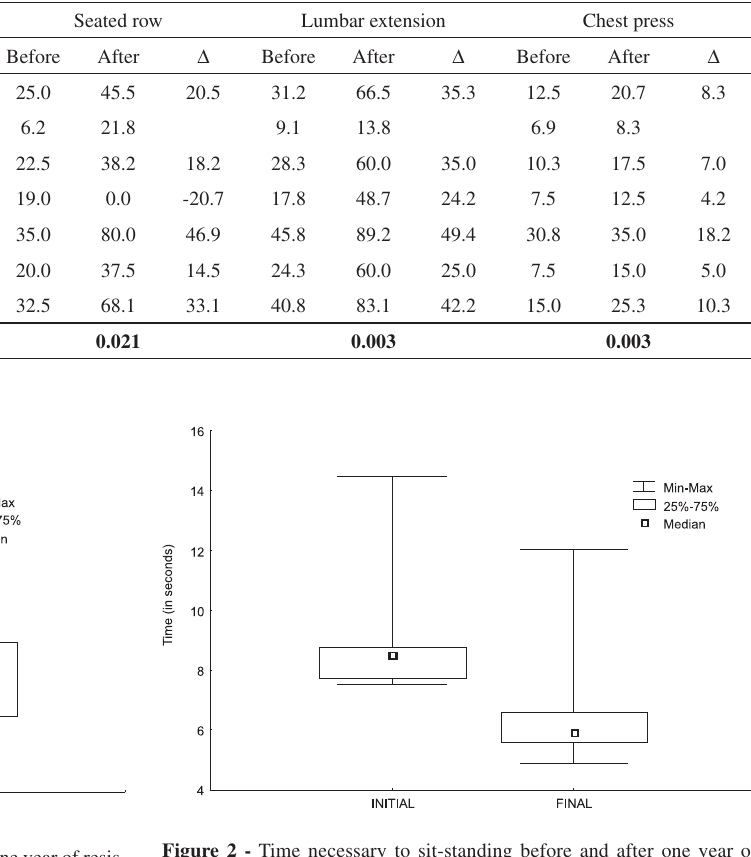
Figure 1 - Time necessary to walk 2.4 m before and after one year of resis- tance training ( p =0.003) Table 3 - Variation of anthropometric measures before and after one year of resistance training Anthropometric measures Before After Variation ( ∆ )